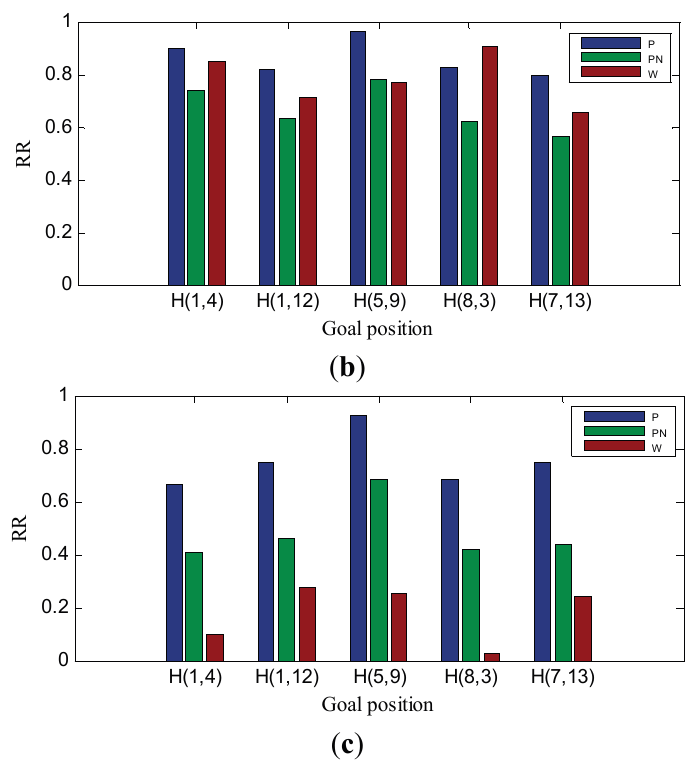
Figure 10. Return ratio (RR) results. ( a – c ) The RR for five goal positions under the experiment conditions: original-original, original-arboreal and